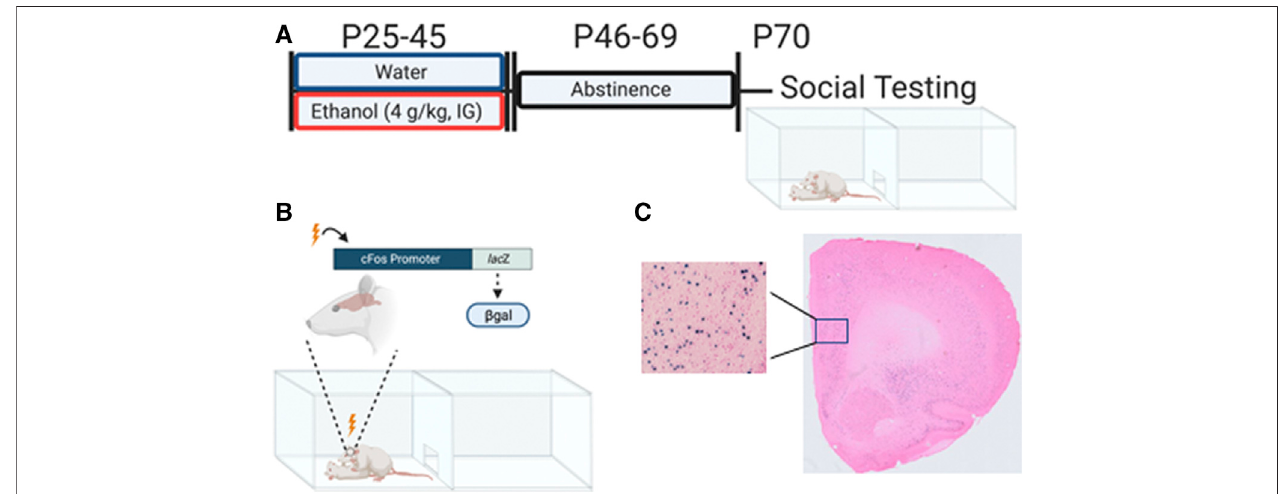
FIGURE1| Adolescent intermittentethanolexposure and β -galexpression associated withsocialinteractioninadulthood. (A) Experimental timeline ofadolescent intermittent ethanol exposure and social interaction testing in adulthood. (B) cFos-LacZ transgenic model allows for measuring β -galactosidase ( β -gal) expression as a proxyfor cFos. (C) Representative X-gal enzymatic labeling ofactive neurons containing( β -gal) following interactionwith anunfamiliar socialpartner. Figure was created using BioRender.com